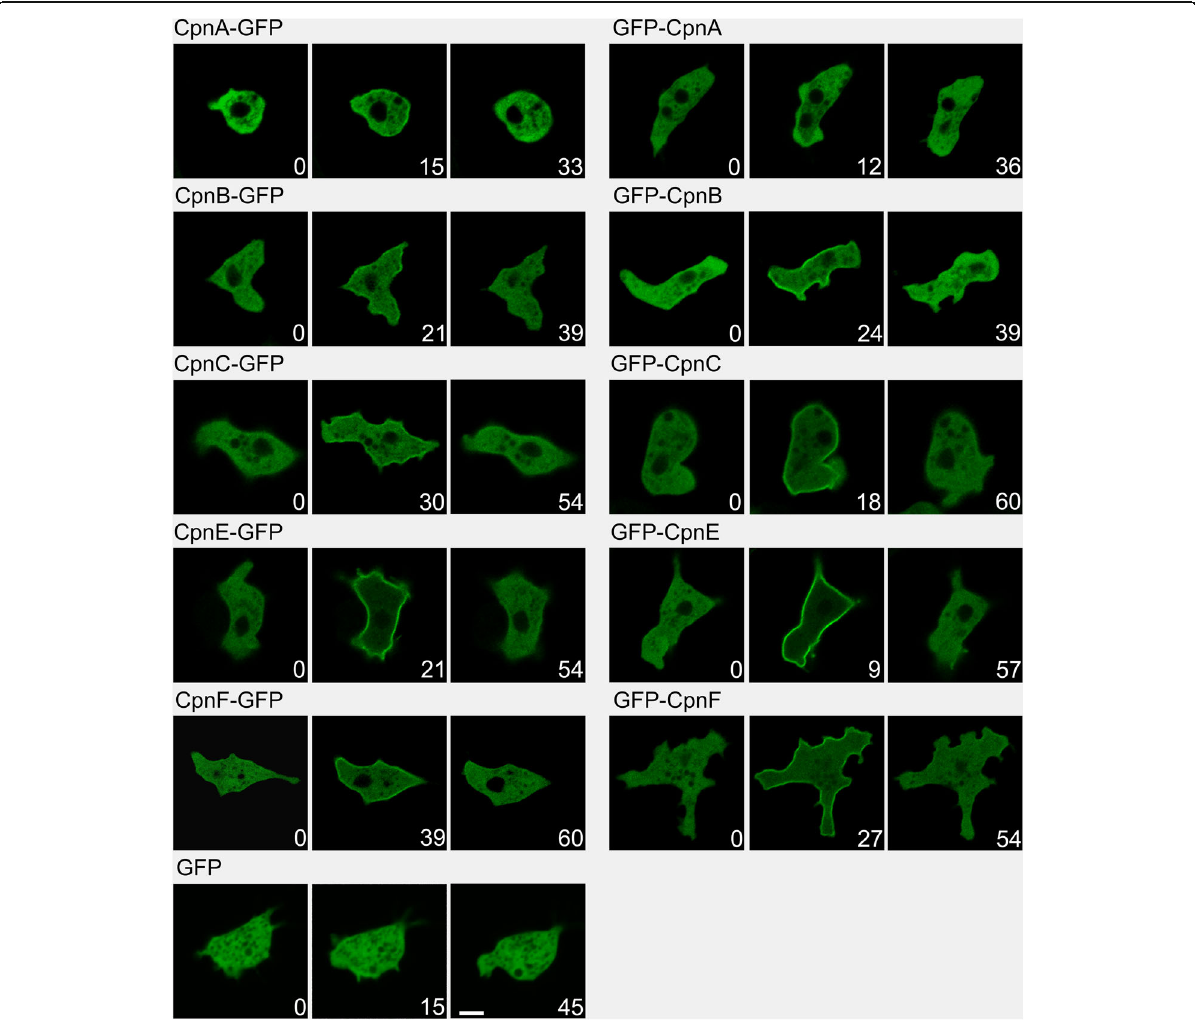
Fig. 3 GFP-tagged copines translocate to the plasma membrane in response to cAMP stimulation. Cells expressing GFP or a GFP-tagged copine were pulsed with 50 nM cAMP every 6 min for 5 h prior to plating cells in glass bottom dishes with 2 mM caffeine and 2 mM CaCl 2 . Cells were stimulated with cAMP and time-lapse images were obtained every 3 s after stimulation, time (seconds) of the image is noted in bottom right corner of each micrograph. Images were obtained with a Nikon Eclipse Ti inverted laser scanning confocal microscope using a 60× oil